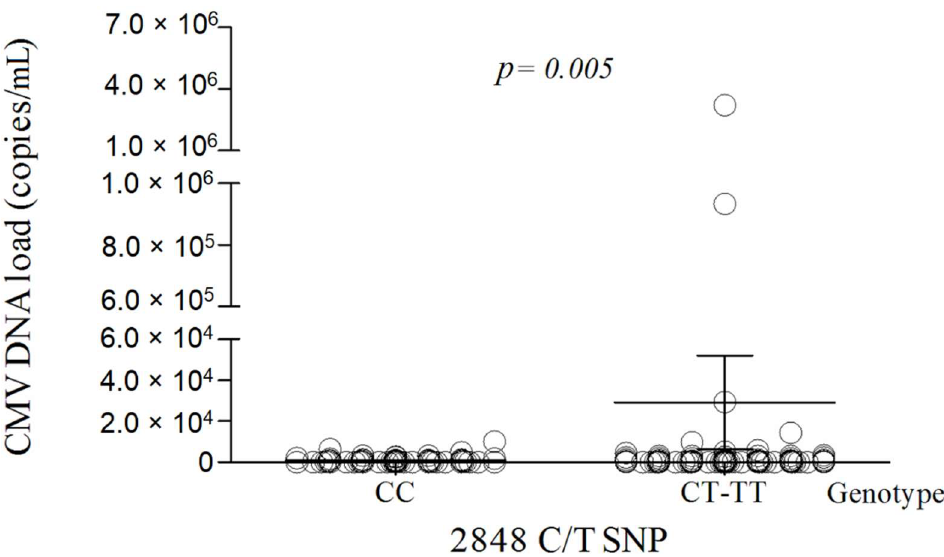
Figure 1. Comparison of the CMV DNAemia level in HIV/CMV co-infected subjects with or without the specific TLR9 2848C/T SNP ( n = 205). Bars in the scatter dot plot represent the mean viral loads and whiskers represent the standard error of the mean (SEM) values. p -value via a Mann–Whitney U